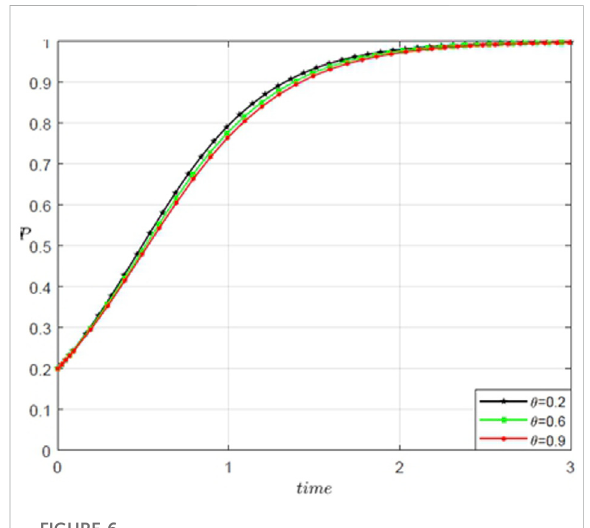
FIGURE 6 The effect of extra cost ( θ ) on the evolution of ECSNs when one party cooperates negatively.